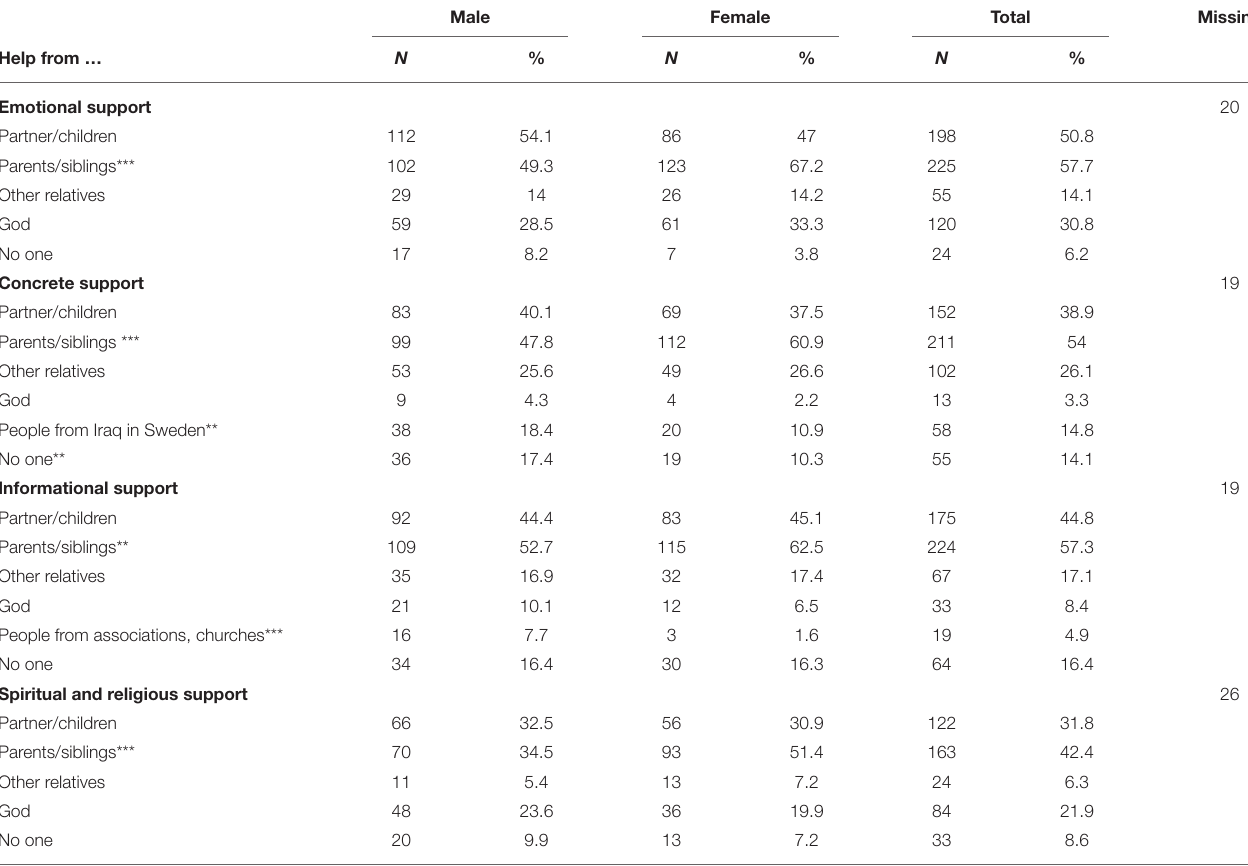
TABLE 4 | Frequency and percentage for social support, by gender, in Sweden. Male Female Total Missing Help from … N % N % N %